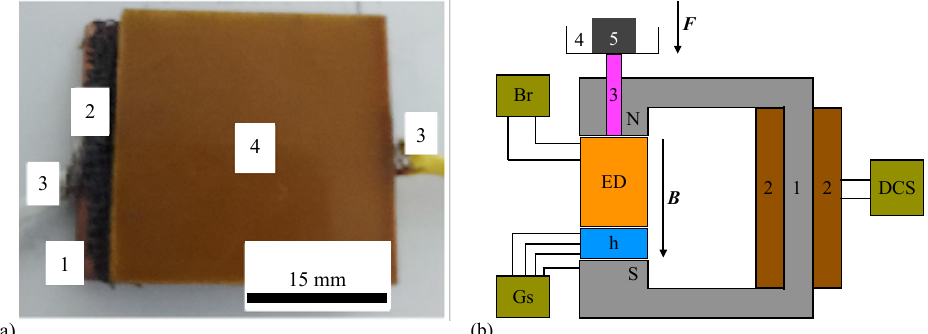
Figure 7. ( a ) Assembled electrical device: 1—copper-coated side of plates, 2—magnetizable CMs, the same illumination conditions as those used for the image in Figure 5. ( b ) The experimental